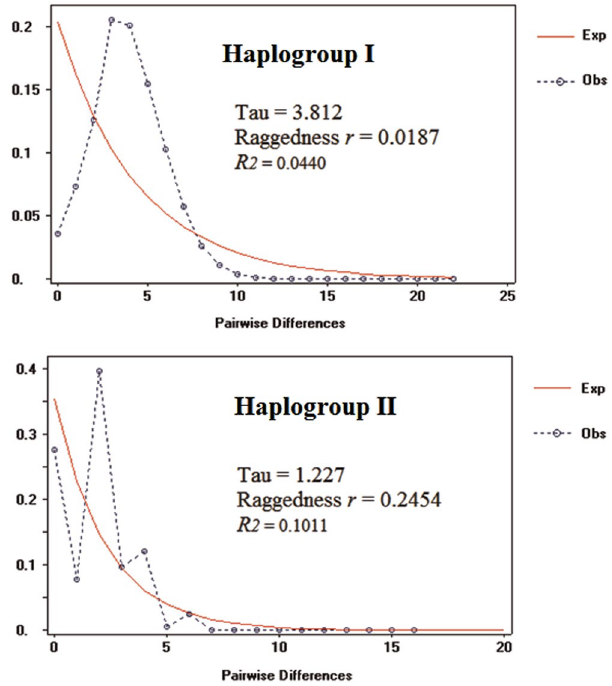
Figure 5. Observed and expected mismatch distributions for Haematobia exigua haplogroups in Southeast